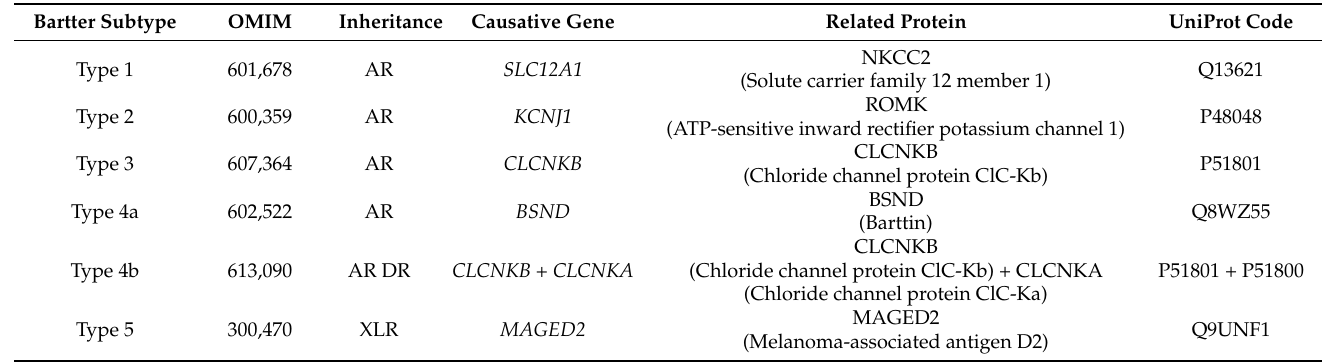
Table 1. Bartter syndrome classification, associated genes and encoded proteins. All the UniProtein codes are referred to Homo sapiens. AR: Autosomal Recessive; DR: Digenic Recessive; and XLR: X-Linked Recessive. Bartter